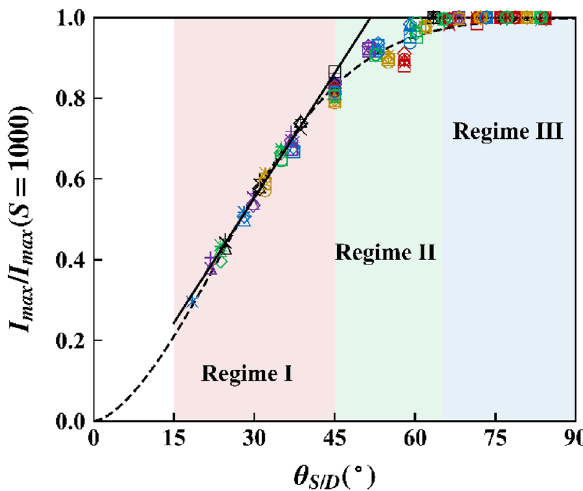
Figure 6. Normalized I max for various θ S / D and V a . Regime I: multiple wire, II: transition, and III: single-wire- behaved (red: D = 50 mm, yellow: 80, green: 114.3, blue: 150, purple: 200, black: 250; ○ : V a = 45 kV, □ : 50, ◇ : 55, △ : 60, : 65, + : 70). ×